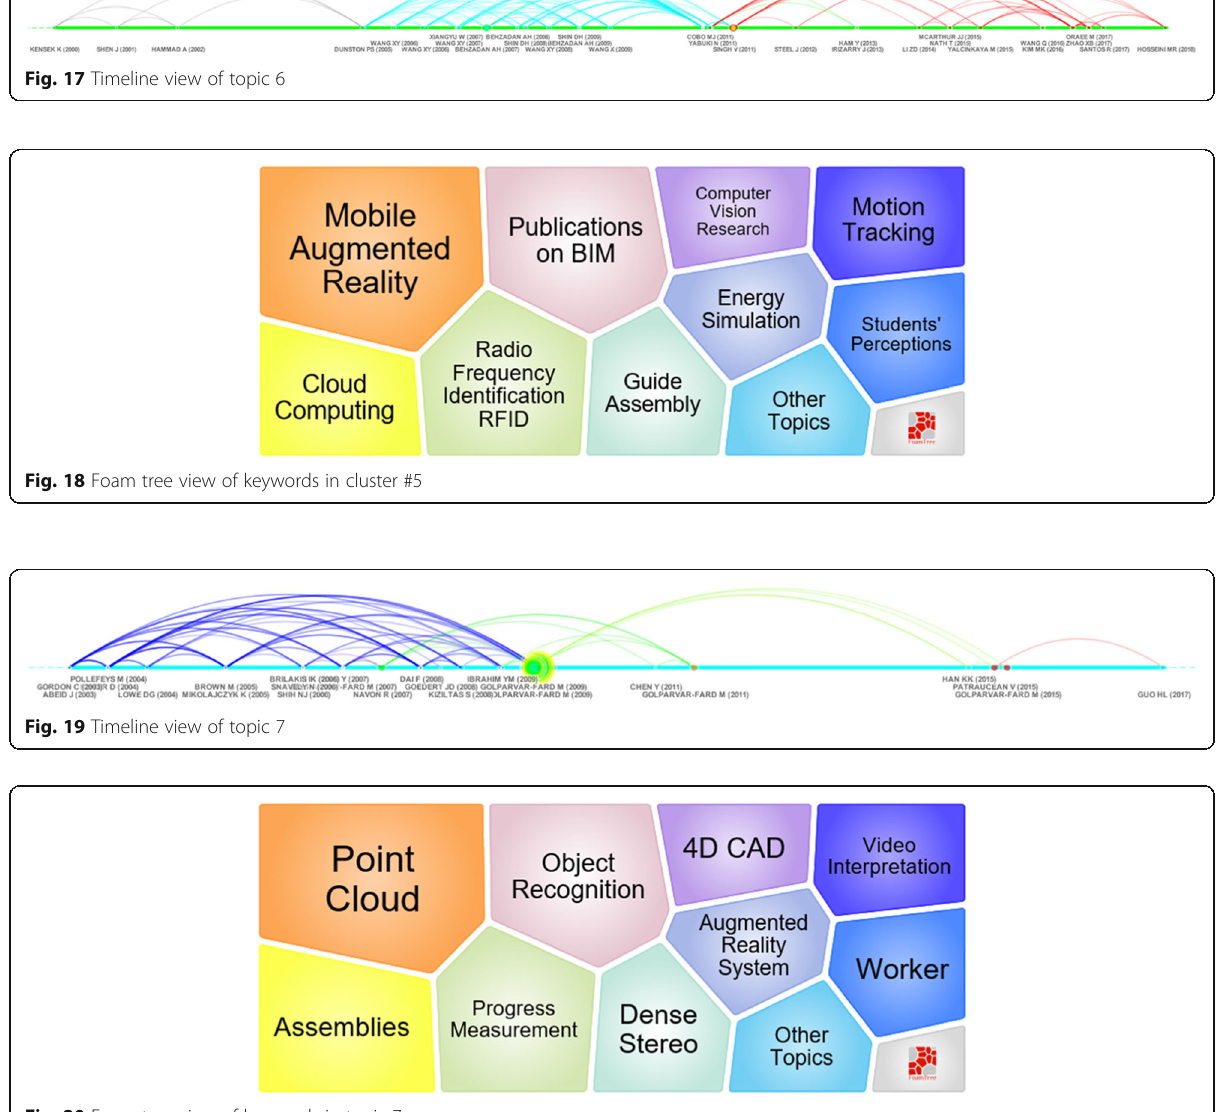
Fig. 20 Foam tree view of keywords in topic